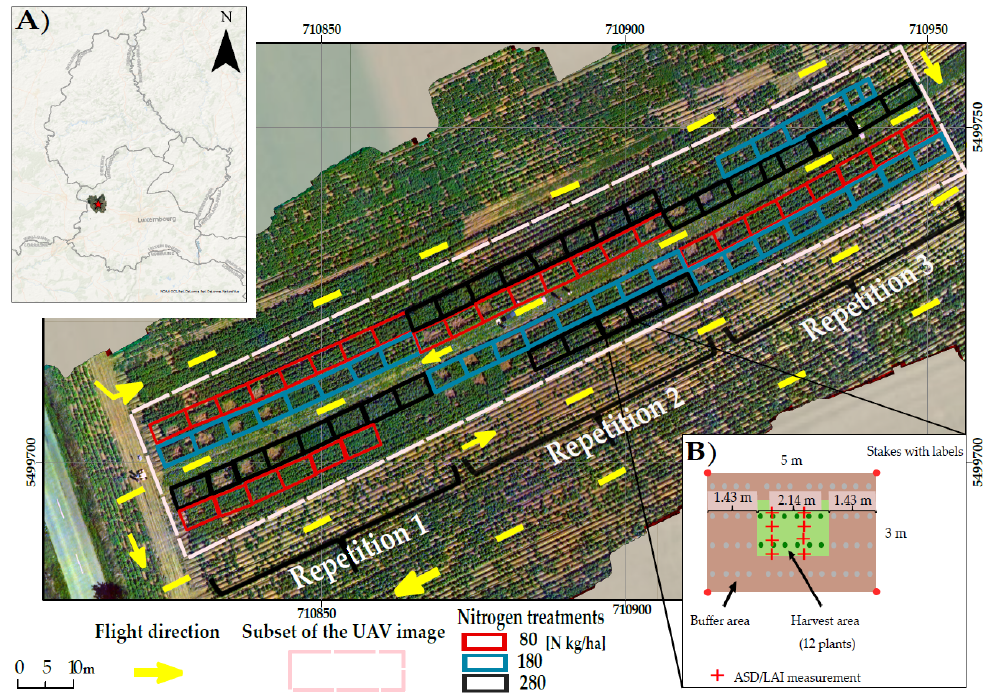
Figure 1. ( A ) A map of Luxembourg, containing the exact location of the study site (the red star). Main map: Image of the UAV orthomosaic, based on the true RGB color captured by the drone on 19 July at an altitude of 50 meters (12:15 pm); and ( B ) the plot design for in situ measurements